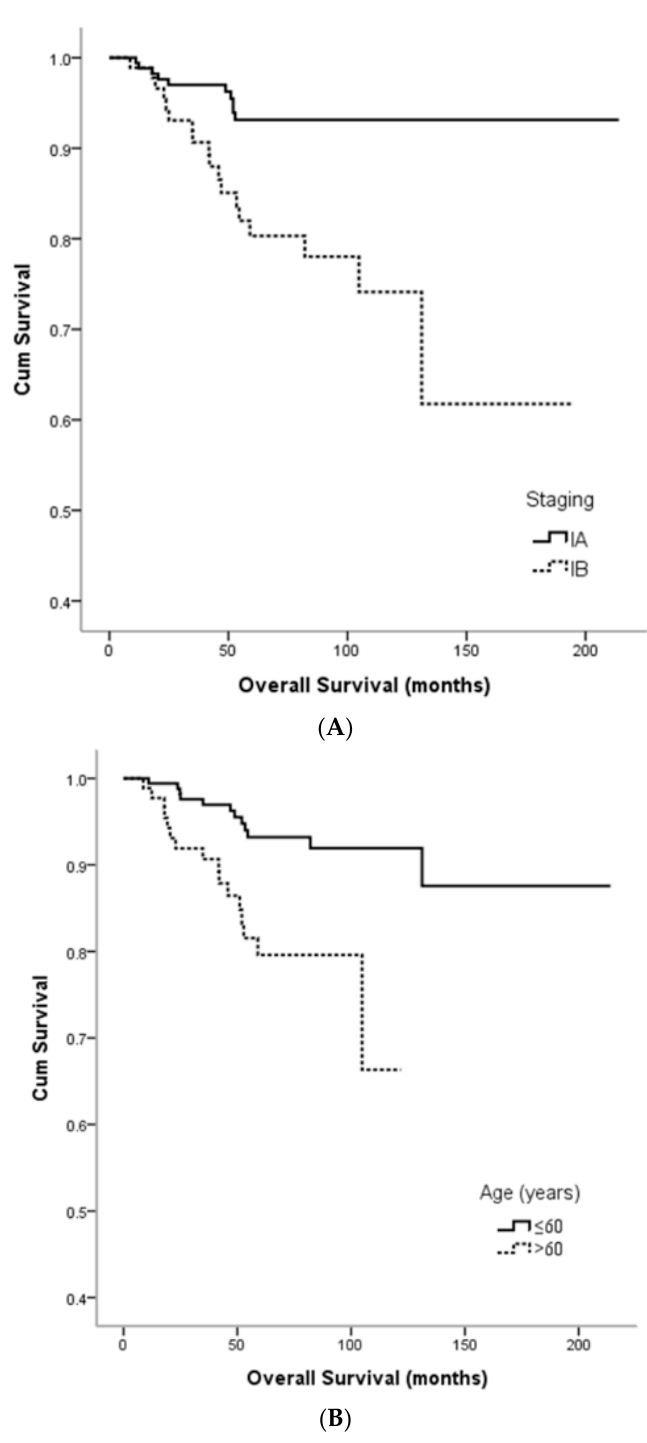
Figure 1. Kaplan-Meier survival estimates according to stage and age. ( A ) Overall survival according to stage (log-rank: IA vs. IB, p < 0.001); ( B ) Overall survival according to age (log-rank: ≤ 60 years vs. >60 years, p = 0.001).